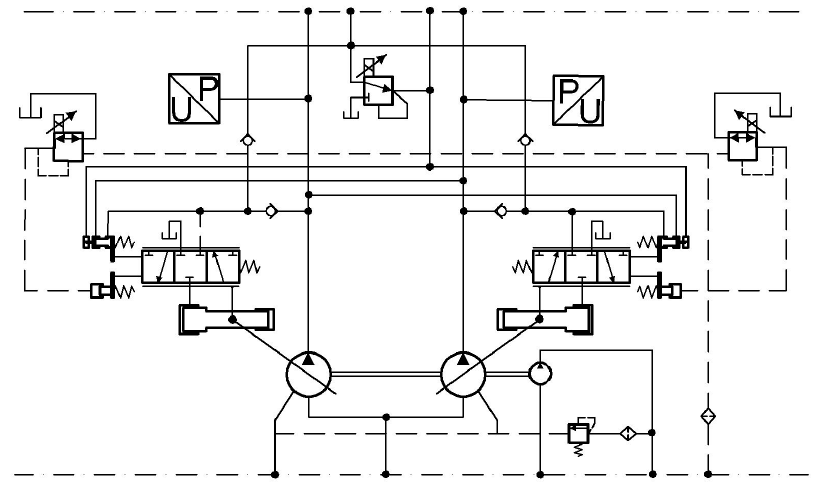
Figure 4. Negative flow-limit load control